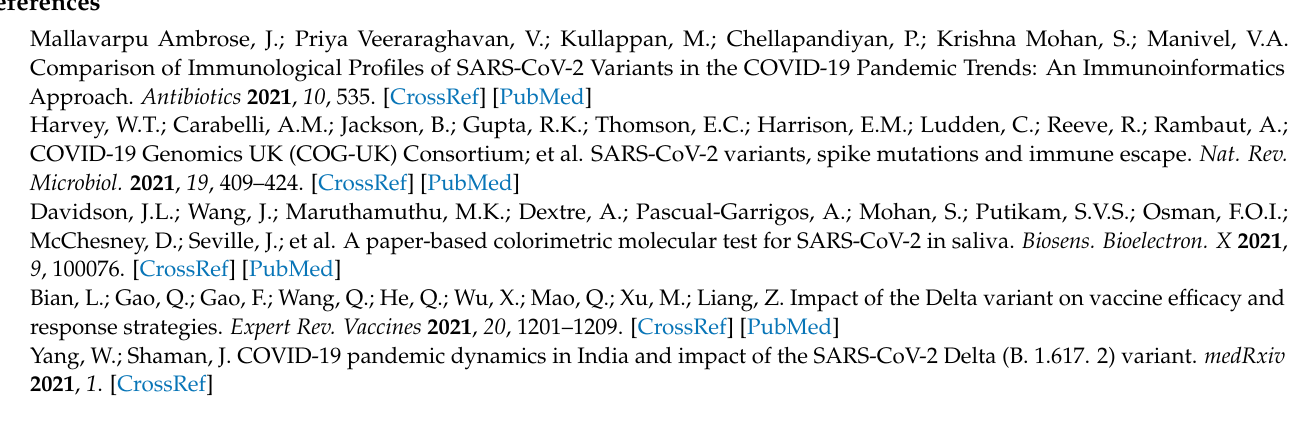
Supplementary Materials: Table S1: Docking based virtual screening results of the 50 phytochemical compound dataset against wild-type Spike protein, predicted by PyRx, Table S2: Docking based virtual screening results of the 50 phytochemical compound dataset against Delta Spike protein, predicted by PyRx, Figure S1: (A) A snapshot of the grid box enclosing the binding pocket of the representative macromolecule (B) Dimensions of the grid box set up around the ligand binding cavity of the